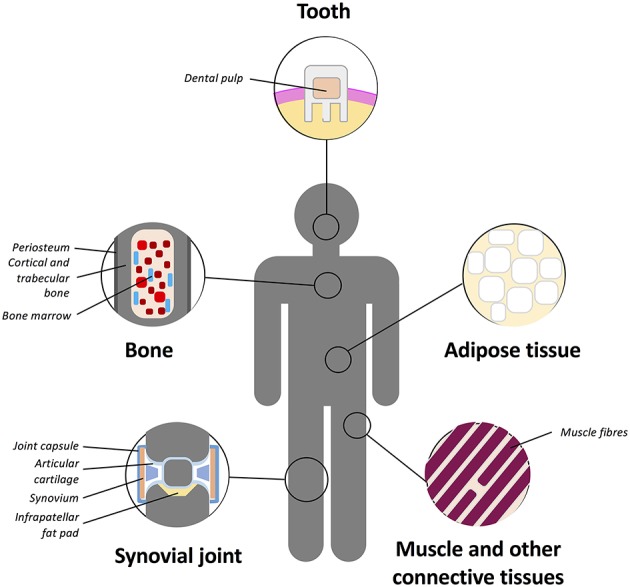
Schematic representation of the main tissue reservoirs of MSCs in the human body. MSCs have been found in the bone marrow, adipose tissue, articular cartilage, synovium, skeletal muscle, dental pulp, circulatory system, heart, brain, umbilical cord (including Wharton's jelly), and other connective tissues. Refer to text for further details.